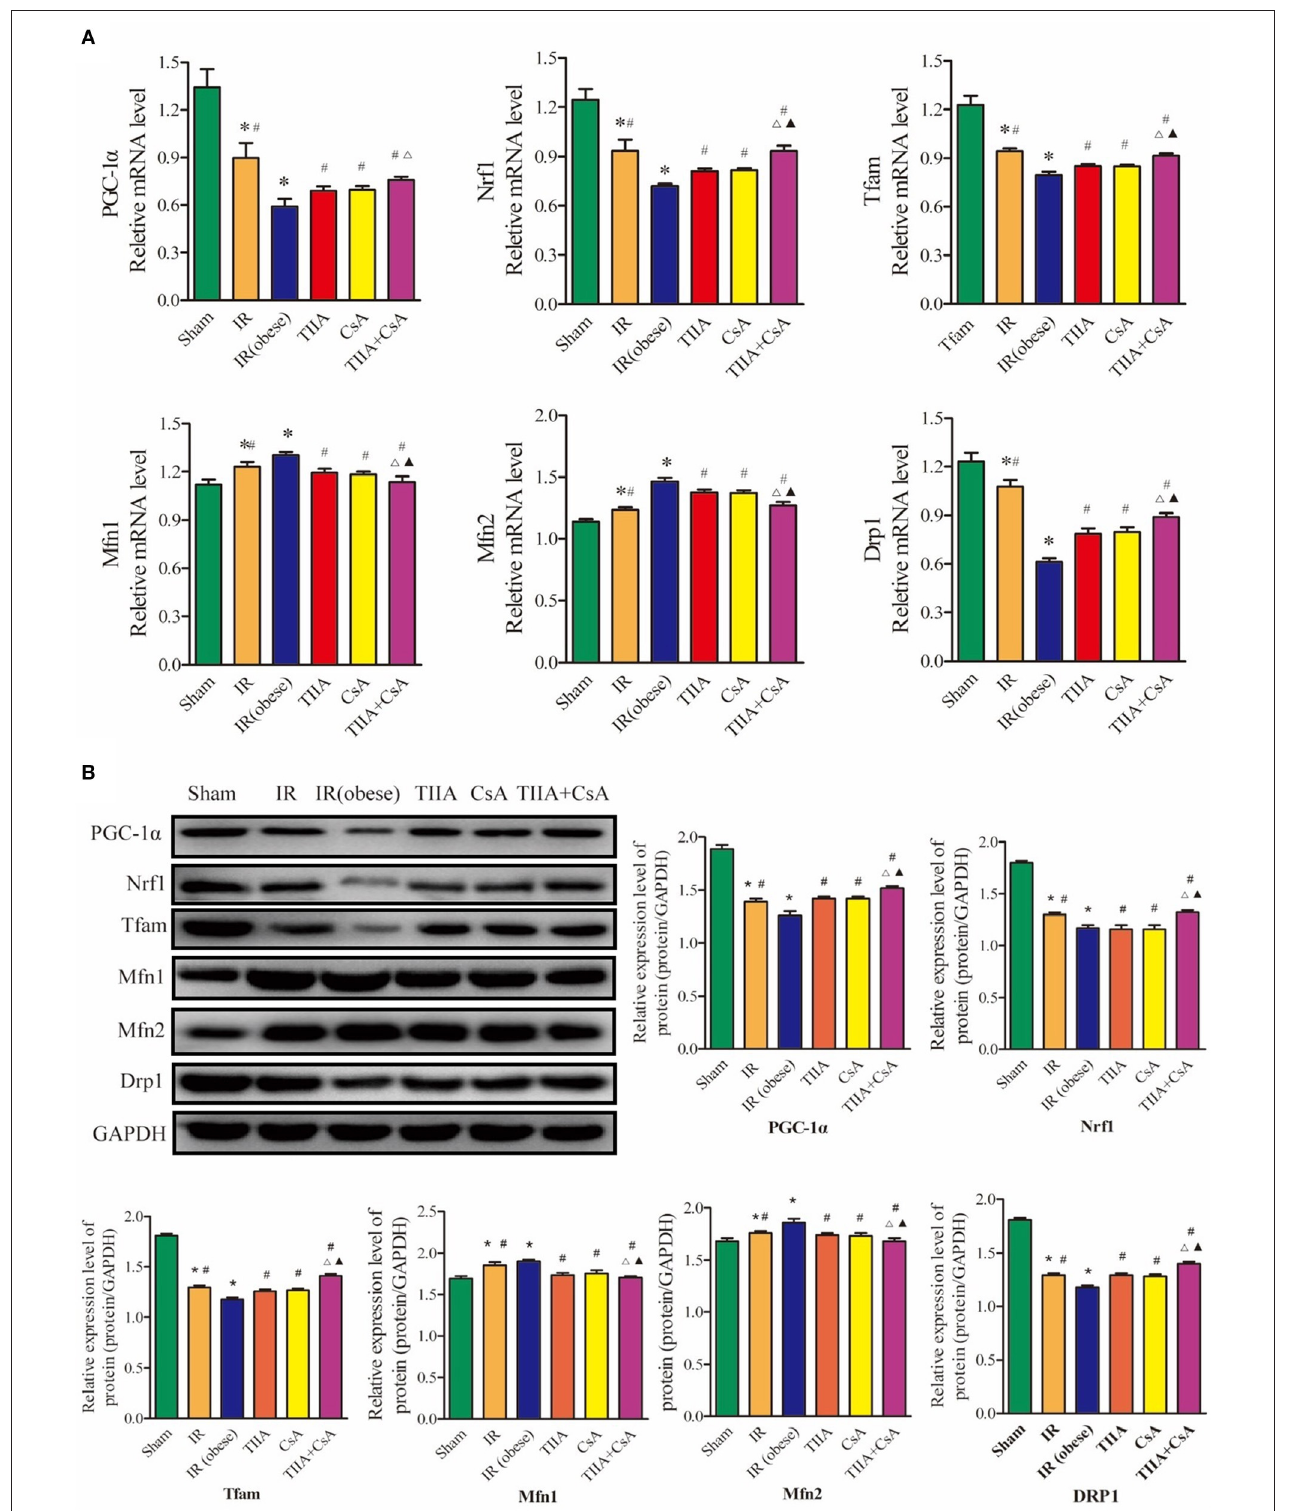
FIGURE 5 | Tanshinone IIA (TIIA) + cyclosporine A (CsA) preserved lung mitochondrial biogenesis and dynamics in renal renal ischemia-reperfusion (IR)-induced lung injury. The expression of PGC-1 α , Nrf1, and Tfam in mRNA (A) and protein (B) levels. The expression of Mfn1, Mfn2, and Drp1 in mRNA level. * p < 0.05 vs. sham group, # p < 0.05 vs. IR (obese) group, △ p < 0.05 vs. TIIA group, N p < 0.05 vs. CsA group.